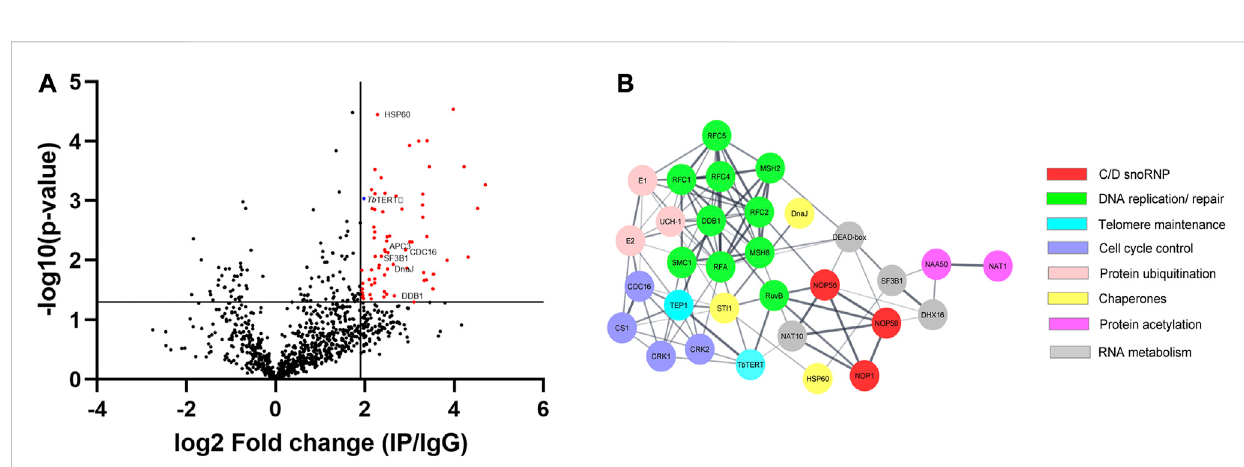
FIGURE 2 (A) Volcano plot was performed with an x -axis representing the difference in logarithmic protein intensities between the Tb TERT immunoprecipitation elution and the isotype matched IgG control (Elution and Control experimental groups). The y -axis is the negative log of the two- sided Student ’ s t-test. The volcano plot serves as a visual representation of the protein groups that are signi fi cantly enriched between the elution and controlgroups.Theseenrichedgroupscontainthebaitprotein Tb TERTandseveralcandidatesinteractingwitha p -value ≤ 0.05. (B) Protein-protein interaction network of relevant Tb TERT hits identi fi ed by MS. Network was generated using the STRING database and visualized using Cytoscape. Colors of nodes represent the protein ’ s biological function. The thickness of the lines denotes the strength of the interaction (con fi dence PPI, threshold: 0.4, medium con fi